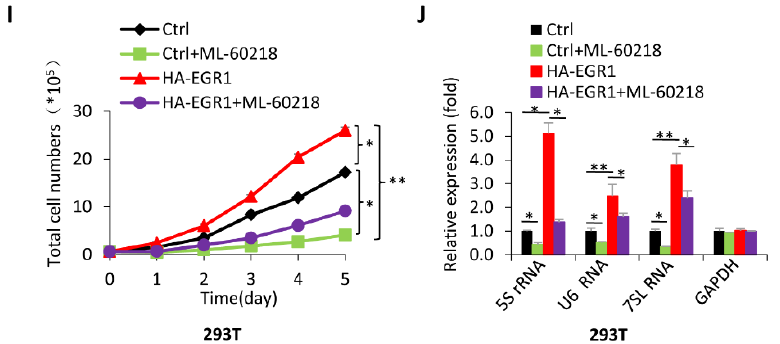
Figure 4. EGR1 may promote cell proliferation by activating Pol-III-directed transcription: ( A , B ) EGR1 knockdown impeded 293T cell proliferation. Briefly, 293T cell lines stably expressing EGR1 shRNA and control shRNA were cultured and subjected to proliferation assays using cell counting ( A ) and MTT assays ( B ); ( C , D ) EGR1 overexpression enhanced 293T cell proliferation activity. In this study, 293T cell lines stably expressing HA–EGR1 and its control cell line were cultured and subjected to proliferation assays using cell counting ( C ) and MTT assays ( D ); ( E , F ) EdU assay results showing the effect of EGR1 knockdown on 293T cell proliferation. The representative images obtained from EdU assays are presented in ( E ). ( F ) represents a statistical result from minimal 5 images; ( G , H ) EdU assay results showing the effect of HA–EGR1 expression on 293T cell proliferation. The representative images obtained from EdU assays are presented in ( G ). ( H ) represents a statistical result from minimal 5 images; ( I ) the presence of ML-60218 repressed the enhancement of cell proliferation caused by EGR1 overexpression. Cell counting was performed using 293T cell lines as indicated; ( J ) the presence of ML-60218 inhibited the activation of Pol III transcription caused by EGR1 overexpression. Pol III products were analysed by RT-qPCR using the total RNA extracted from 293T cell lines as indicated. The scale bars in EdU images represent 50 µ m. Each point or column in graphs represents the mean ± SD of three biological replicates ( n = 3). *, p < 0.05; **, p < 0.01. p values for ( A – D ) were obtained by two-way ANOVA; p values for ( F , H , I ) were obtained using Student’s t -test, performed with control and treatment samples; p values for ( J ) were obtained by one-way ANOVA, followed by Bonferroni test, using a comparison of two groups among multiple